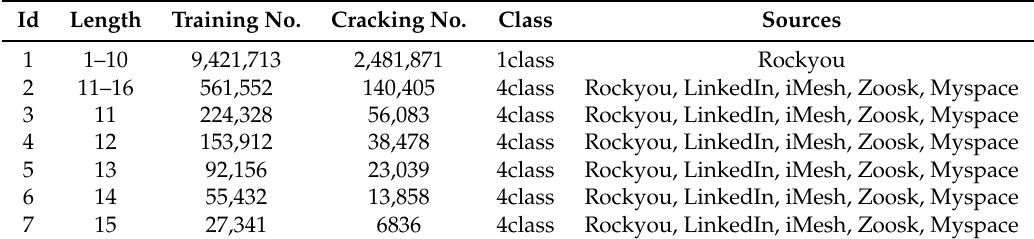
Table 1. Experimental Dataset Summary: we used the plaintext passwords from Hashes.org. 4class set consists of symbols, digits, and upper- and lowercase letters.